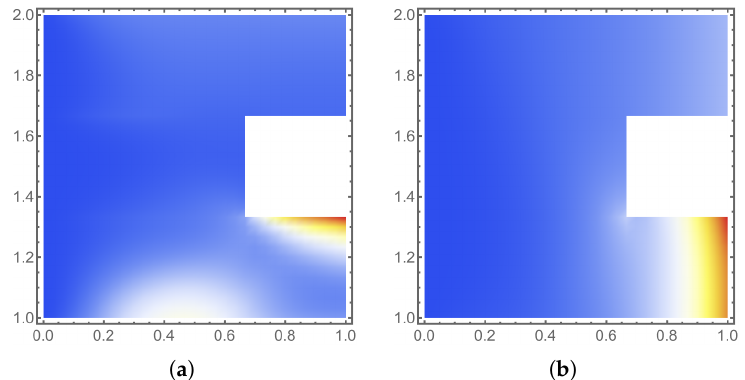
Figure 4. Three layers of uncertain materials. Examples of computed variance. Temperature scale with zero level at the boundary x = 0. ( a ) Var ( u 1 ) ∈ [ 0,0.11 ] , ( b ) Var ( u 2 ) ∈ [ 0,0.83 ] . Decay rates: ζ 1 = ζ 3 = 2, ζ 2 = 3, ε i = 1/100, i =